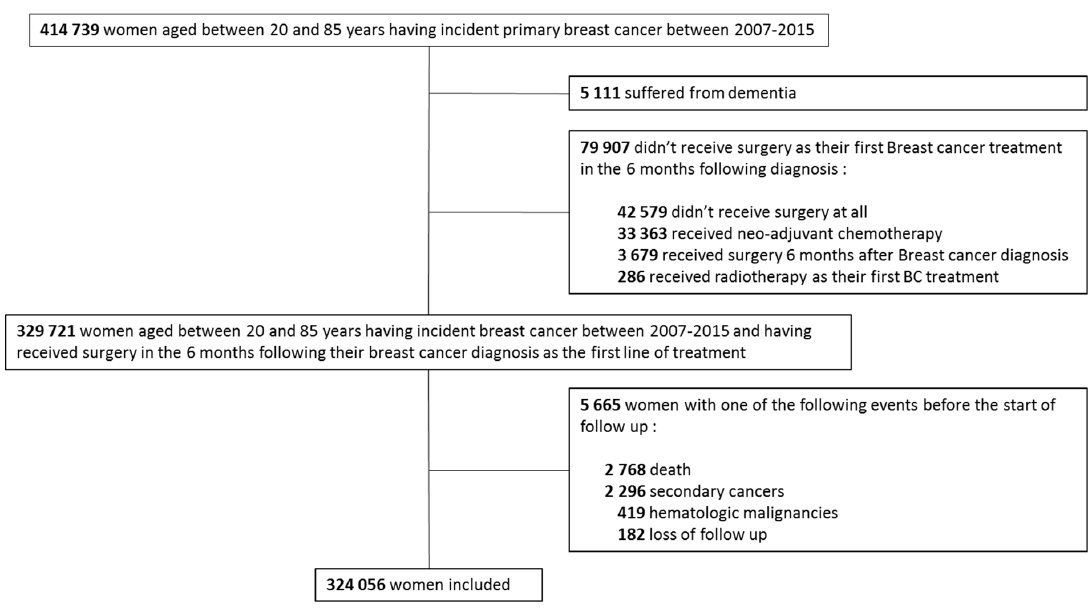
Figure 1. Study flowchart.